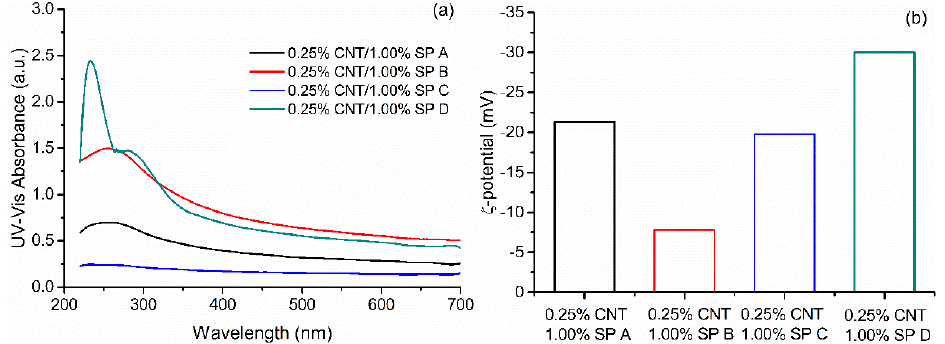
Figure 4. ( a ) UV–Vis absorbance spectra and ( b ) ζ -potential values of different CNT/SP/water dispersions with 0.25% of CNT and 1.00% of all studied SP.